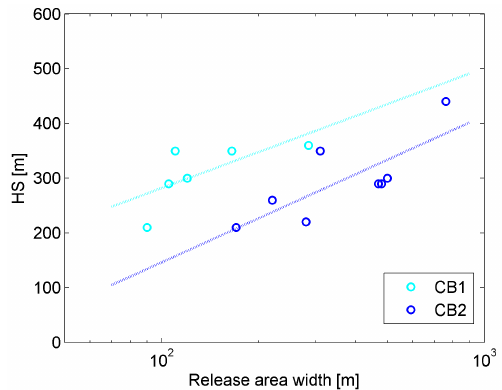
Figure 11. Release area width in the basins CB1 and CB2 as a func- tion of snow depth measured at the weather